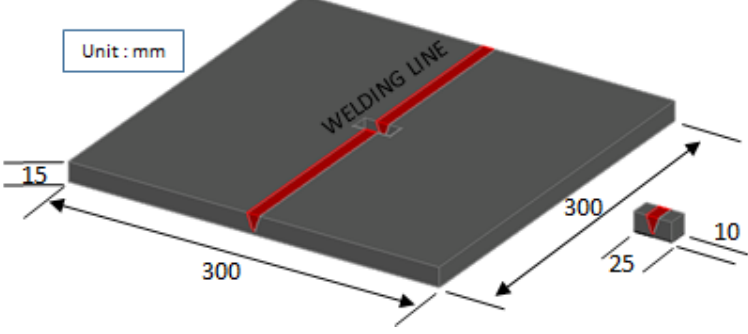
Figure 3. Welding specimen and coupon for cross-section observation.